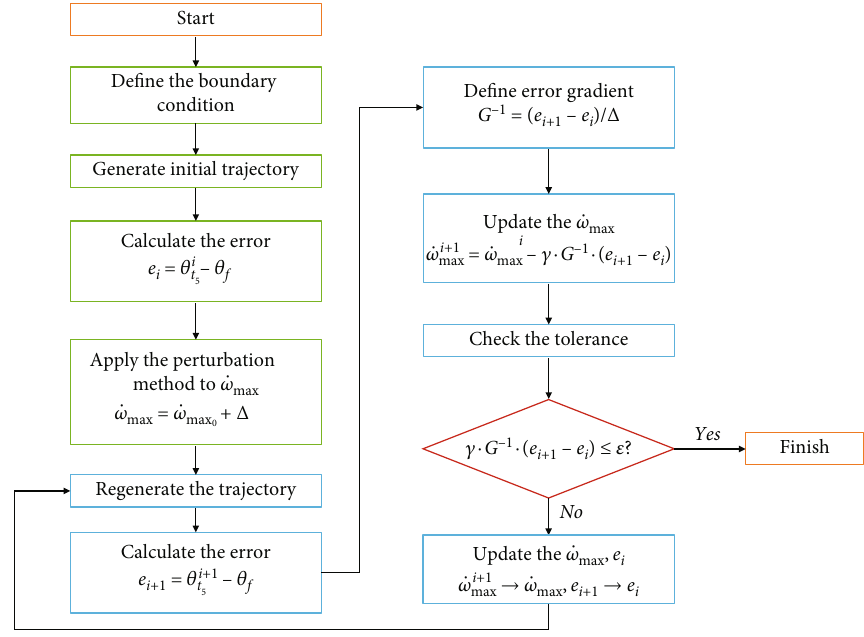
Figure 3: Exact maximum acceleration calculation with the Newton-Raphson method [18]. Table 3: Parameter description for Figure 3.